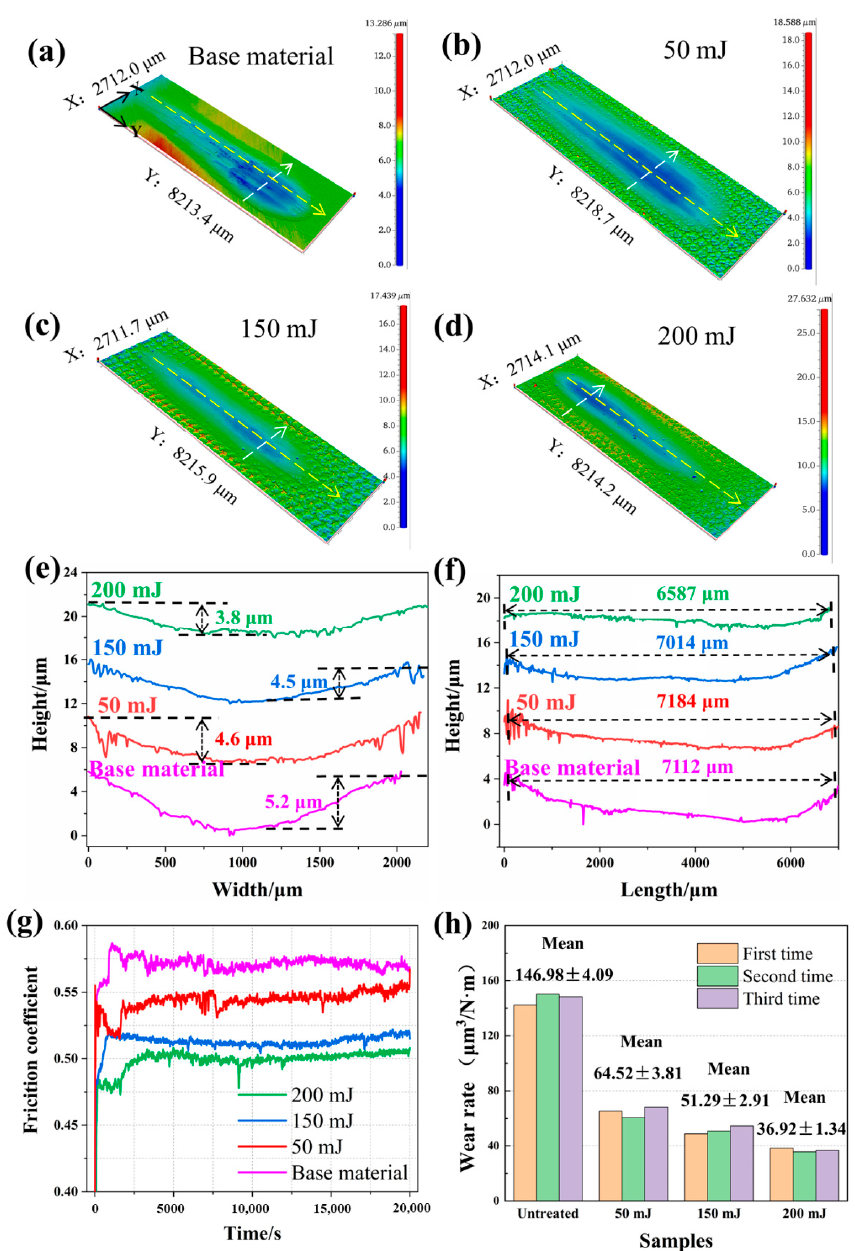
Figure 11. Abraded specimens with different energy treatments. ( a – d ) 3D morphologies; ( e , f ) abra- sion contours; ( g ) friction coefficients; ( h ) wear rates.